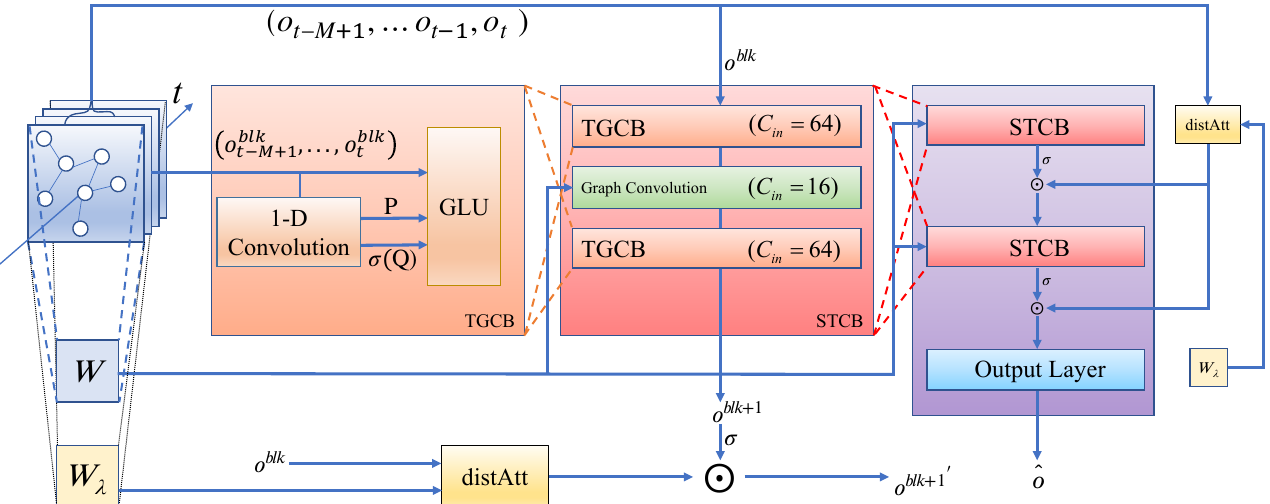
Figure 3. The framework of the proposed HST-GCN model. (cid:12) refers to the element-wise Hadamard product and σ ( · ) refers to the sigmoid